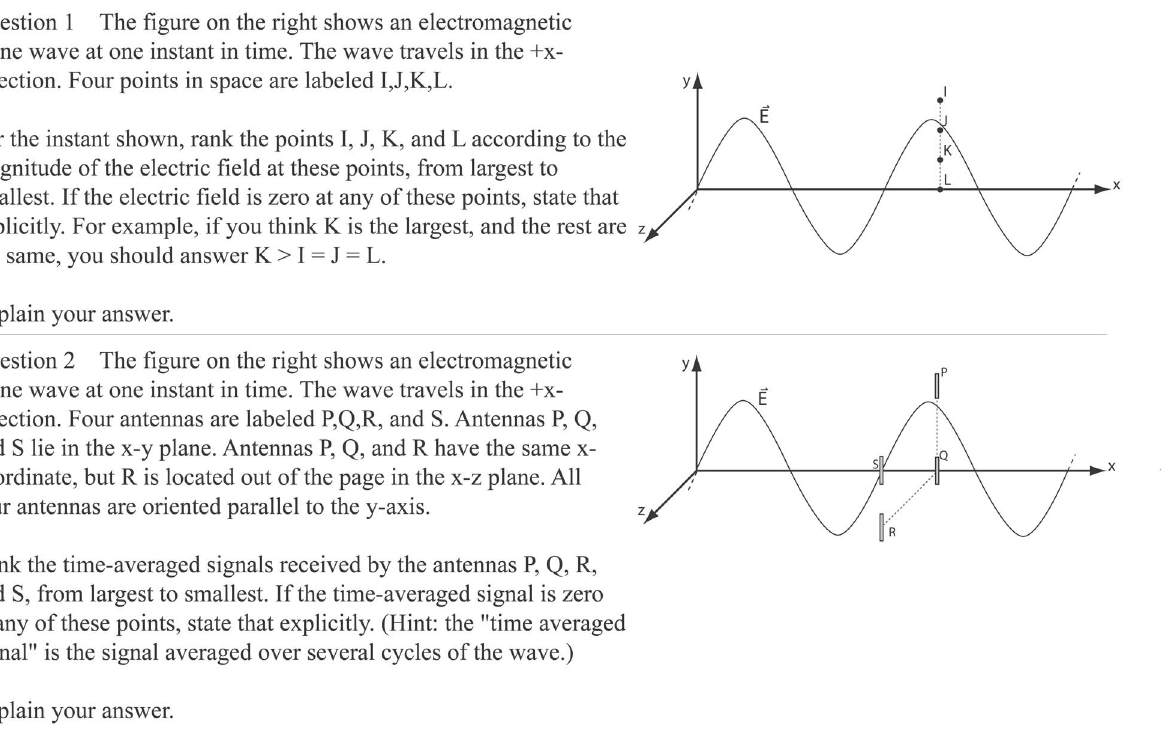
FIG. 2. Questions given on the pre- and post-tests in the across-domain